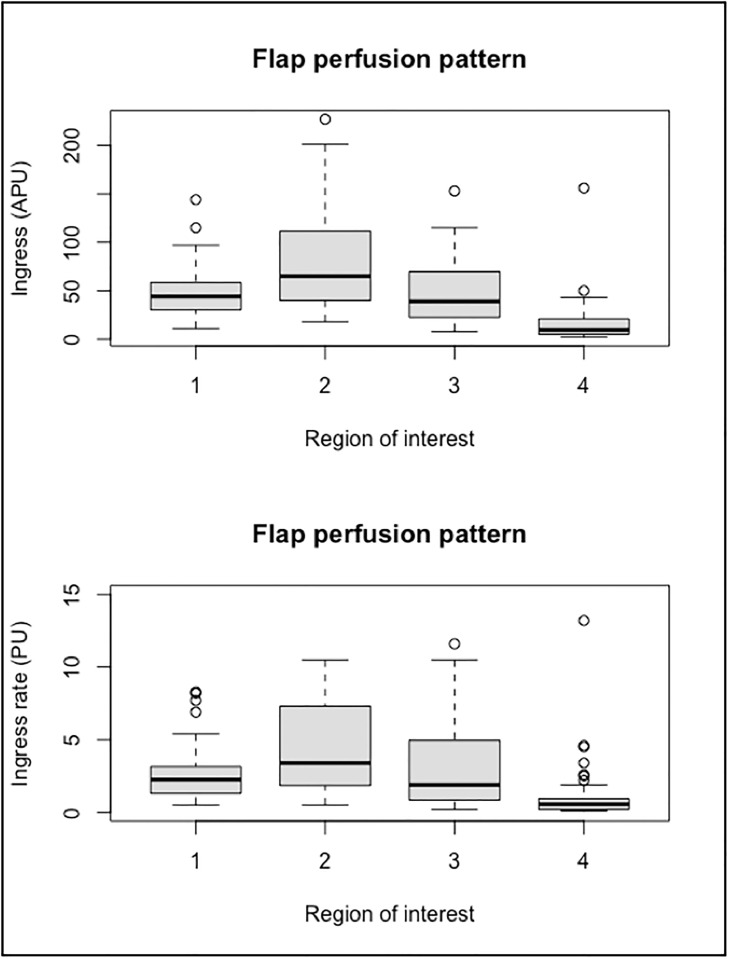
Flap zones and quantitative perfusion parameters.This boxplot figure represents distributions of ingress (above) and ingress rate (below) calculated on the four flap zones as defined above. When quantitatively assessed, perfusion is the higher in ROI 2 (zone I) and the lower in ROI 4 (zone IV).